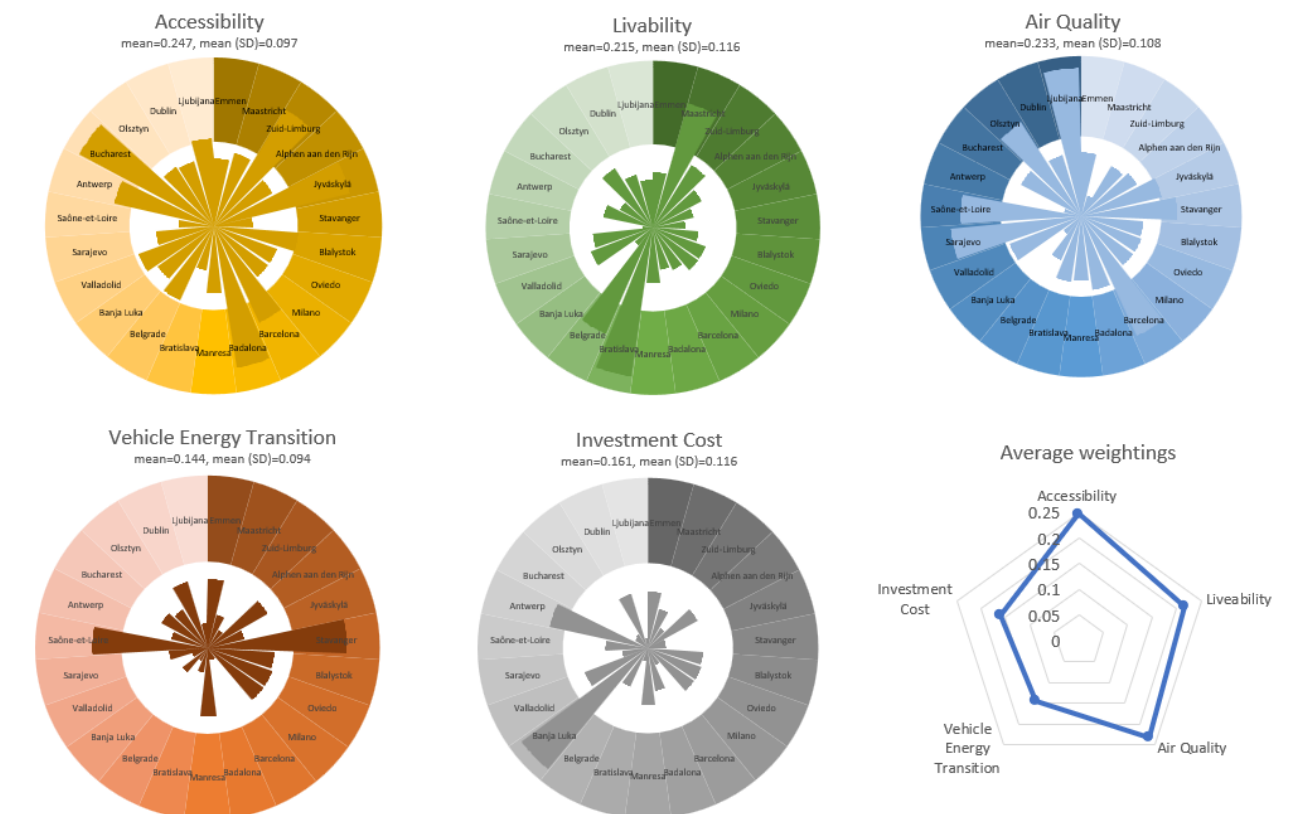
Figure 3. Perceived relative importance of different factors in urban mobility planning, per city and average score ( N = 23